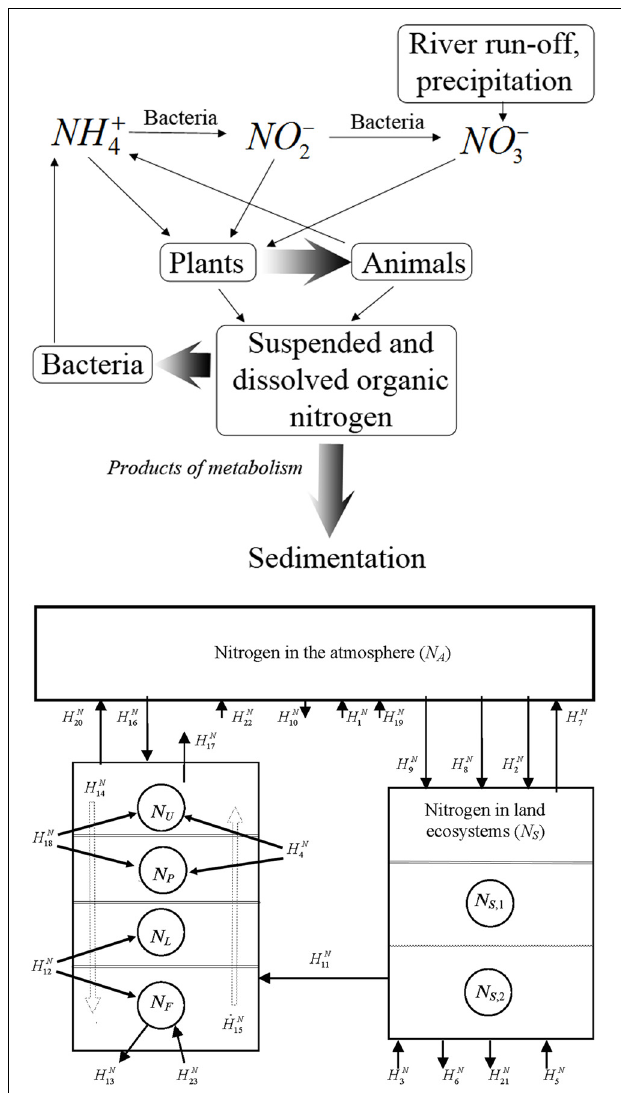
FIGURE 7 | The scheme of nitrogen fluxes in marine medium (top) and in nature (Table 2) (bottom).